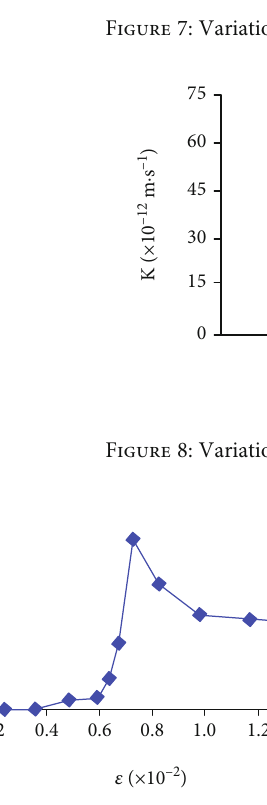
Figure 9: Variation curve of the permeability coe ffi cient K with strain ε